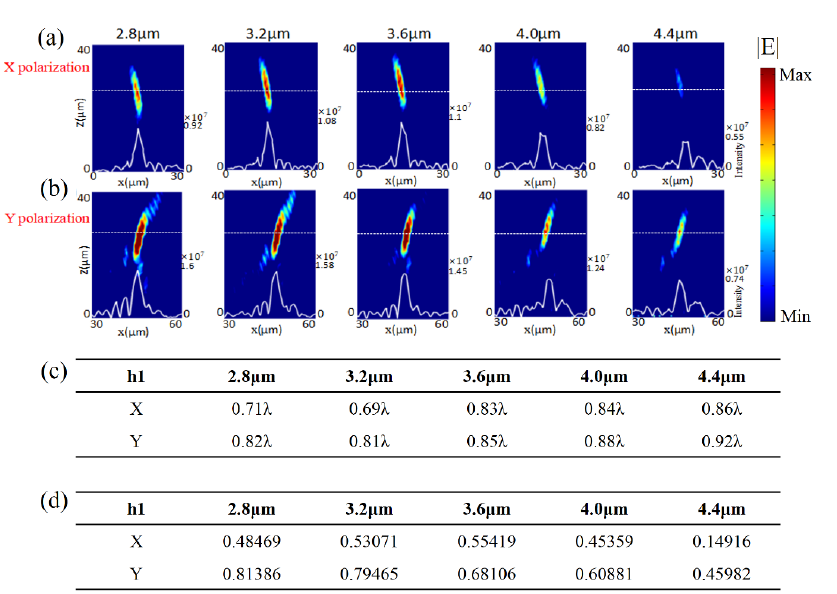
Figure 3. Focusing performance of the transmission metalens at a wavelength of 4.2 µ m when the heights of GaAs nano-bricks were h = 2.8 µ m, 3.2 µ m, 3.6 µ m, 4.0 µ m, and 4.4 µ m (from left to right). Distributions of light intensity in the x - z plane under normal incidences with ( a ) x - and ( b ) y -polarization. The white solid and dash lines are the intensity distribution curve and the position of focal plane, respectively. The number on the right side of each figure is the value of light intensity at the focus. ( c ) Simulated FWHM for each case. ( d ) Simulated focusing efficiency for each case.